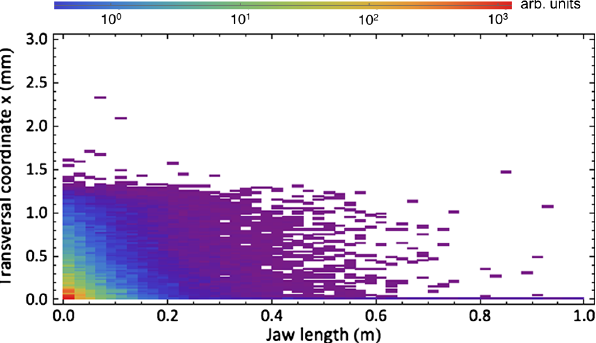
FIG. 12. Density of inelastic interactions in the TCTH.4L1.B1 jaw for Case 2. Simulated losses concentrate in the left jaw, therefore the right one is neglected in the plot. A bin size of 2 cm in s and 20 μ m in x is used. Losses are integrated along y . In this jaw is set at x ¼ 0 .